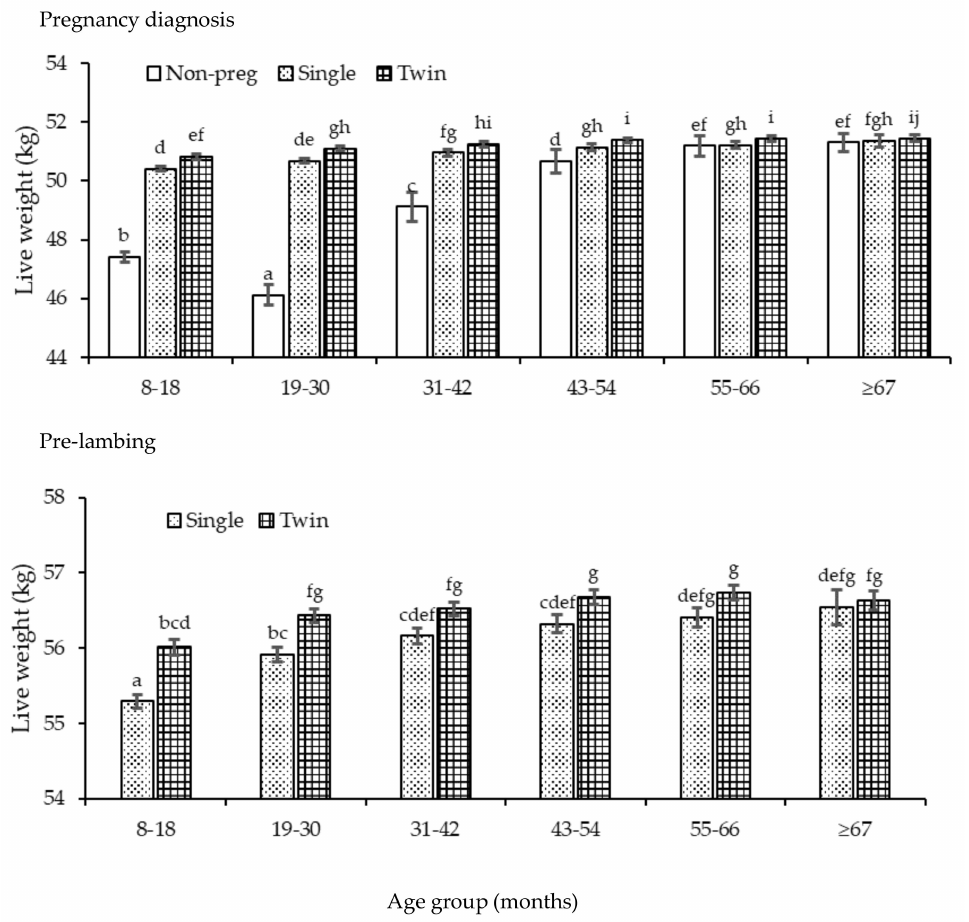
Figure A4. The liveweight of ewes across each age group (8–18 months, 19–30, 31–42, 43–54, 55–66 and ≥ 67) and at pregnancy diagnosis (white bar, non-pregnant; dotted, single, twin). Superscripts a–j indicate significant di ff erences ( p < 0.05) across age group and stage of the annual